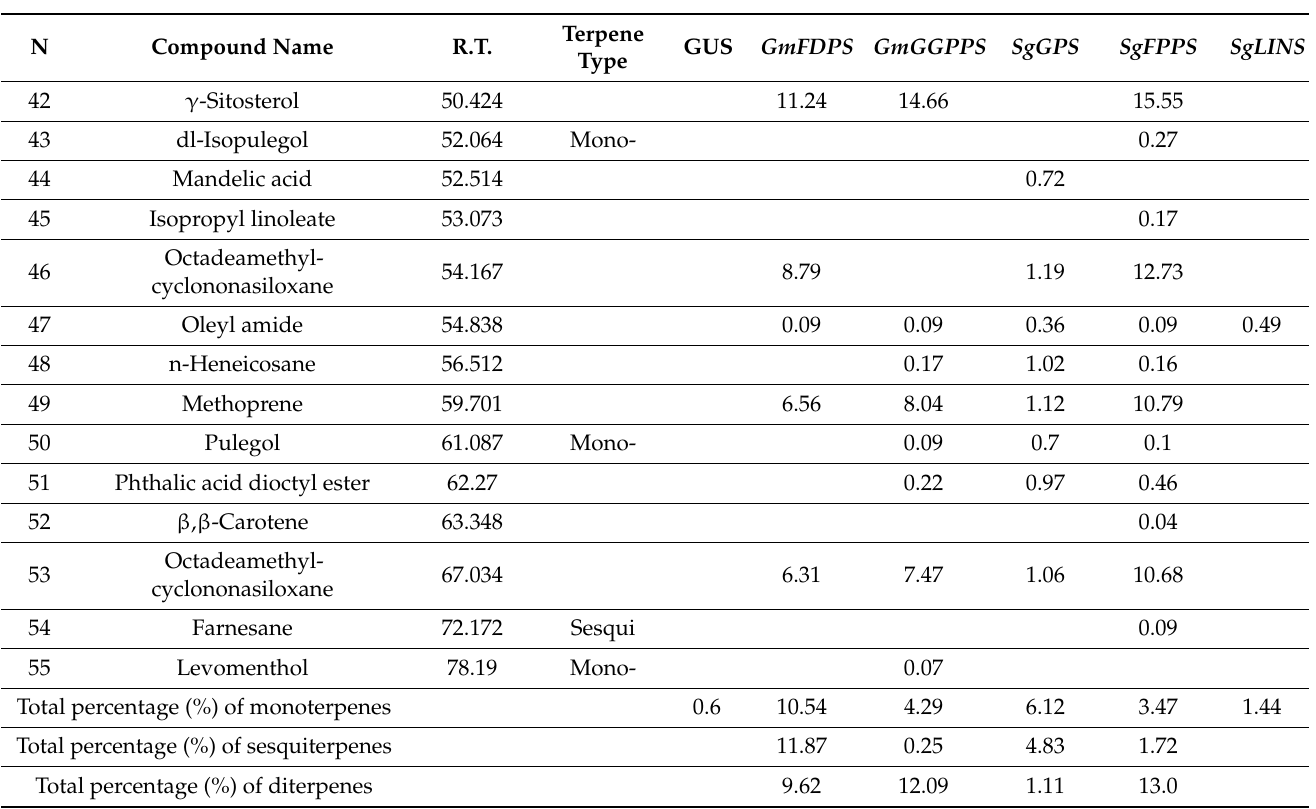
Figure 3A–H. The following root and nodule characteristics were investigated: root length (cm), fresh root weight (gram), fresh nodule weight (gram) and nodule number after 10 and 20 days, as indicated in Figure 4A. GmFDPS, GmGGPPS, SgGPS, SgFPPS , and SgLINS expression were validated in roots and nodules after 10 and 20days by